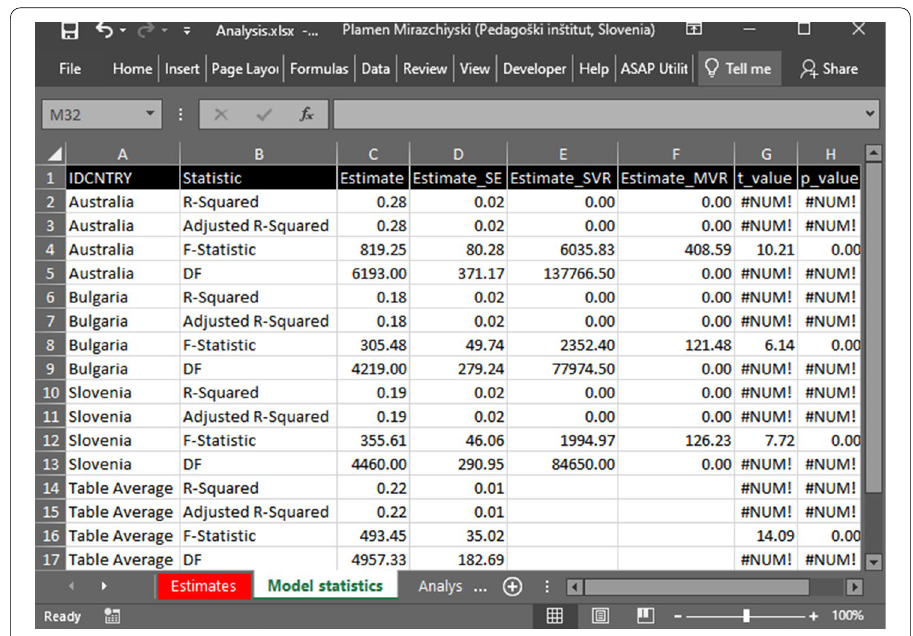
Fig. 5 Model statistic output sheet from the lsa.lin.reg